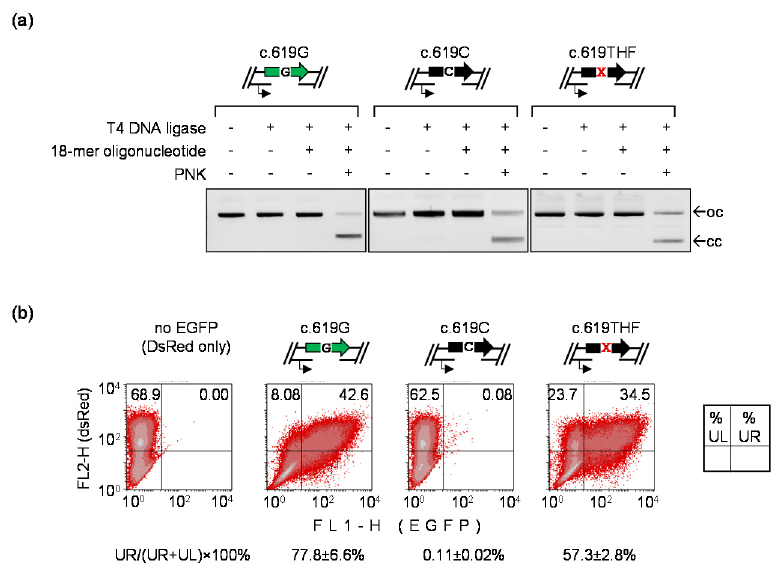
Figure 5. Detection of mutagenic TLS over the synthetic AP lesion in the EGFP A207P (c.619G > C) reporter by reversion to the fluorescent phenotype: ( a ) verification of the presence of gaps in the TS opposite to the specified nucleotides in the TLS reporter constructs by inhibited ligation and its reconstitution with matching synthetic 18-mer oligonucleotides. THF lesion at the nucleotide 619 is marked with “X”; ( b ) Repair of the 18-nt gap by re-synthesis of the missing TS fragment in the construct encoding the functional EGFP (c.619G) and detection of mutagenic TLS on the EGFP A207P template containing no modification (c.619C) or AP lesion (c.619THF) at the nucleotide 619. HeLa cells were transfected with the indicated constructs together with the DsRed-Monomer expression vector as a transfection marker. The fractions of EGFP-positive cells (UR / (UR + UL) × 100%) were used as an estimate of the repair and mutation rates, as in Figure 1 ( n = 2 independent experiments, mean ±